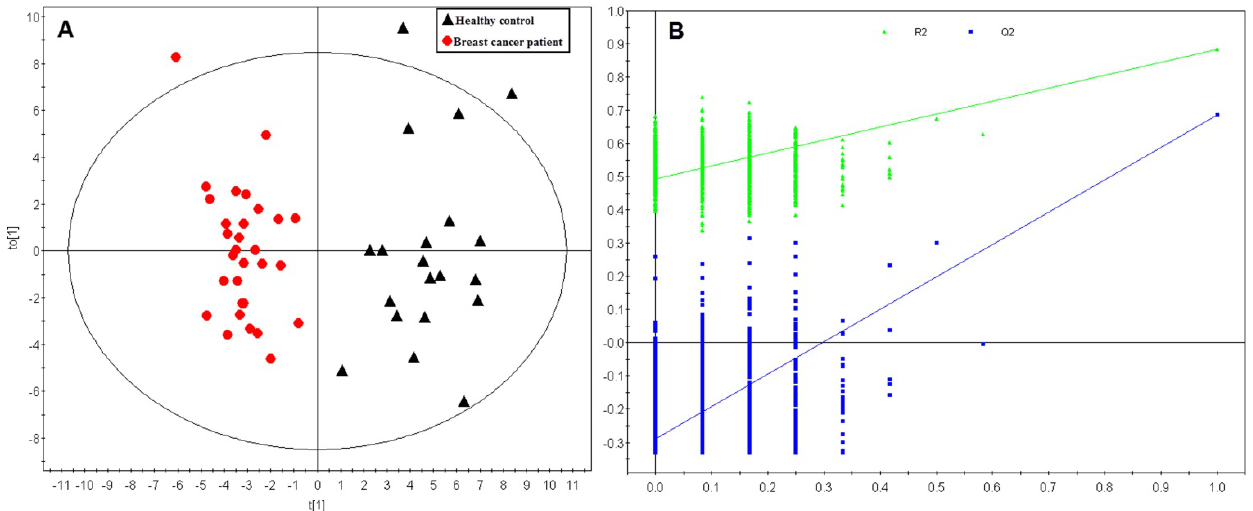
Figure 2. Orthogonal partial least squares-discriminant analysis (OPLS-DA) scores plot and permutation test for the model discriminating plasma samples from breast cancer patients and healthy controls in the training dataset. ( A ) OPLS-DA scores plot. The model parameters were: R2Xcum = 0.464, R2Ycum = 0.884, Q2 = 0.756. Each red dot represents one breast cancer patient, while each black triangle represents one healthy